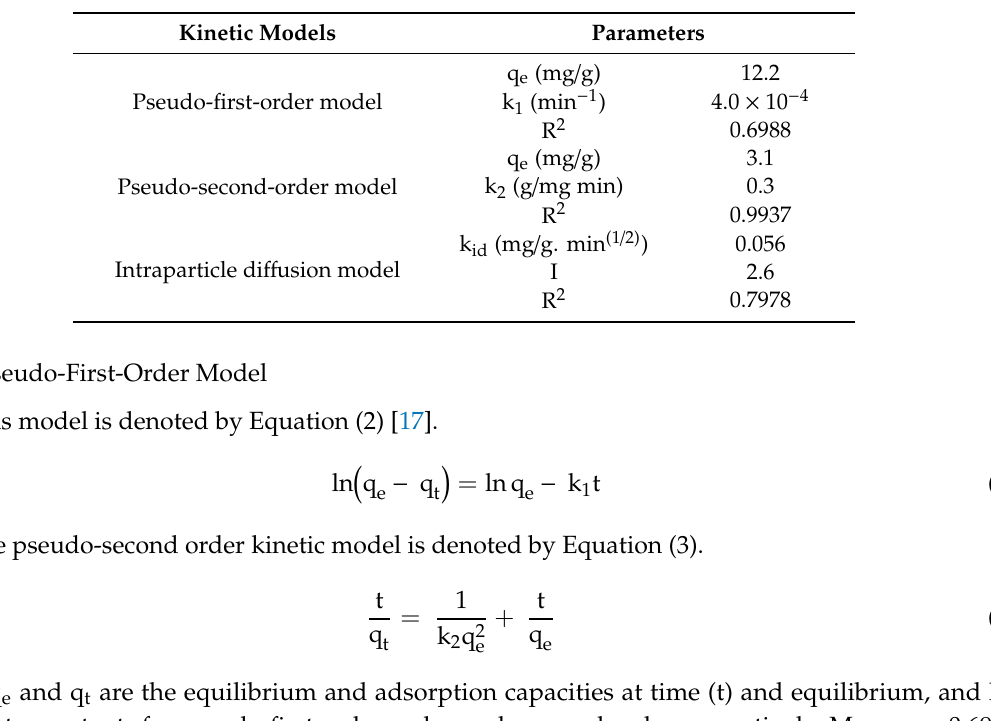
Table 2. Kinetic parameters for the removal of Ni(II) ion by DSP.